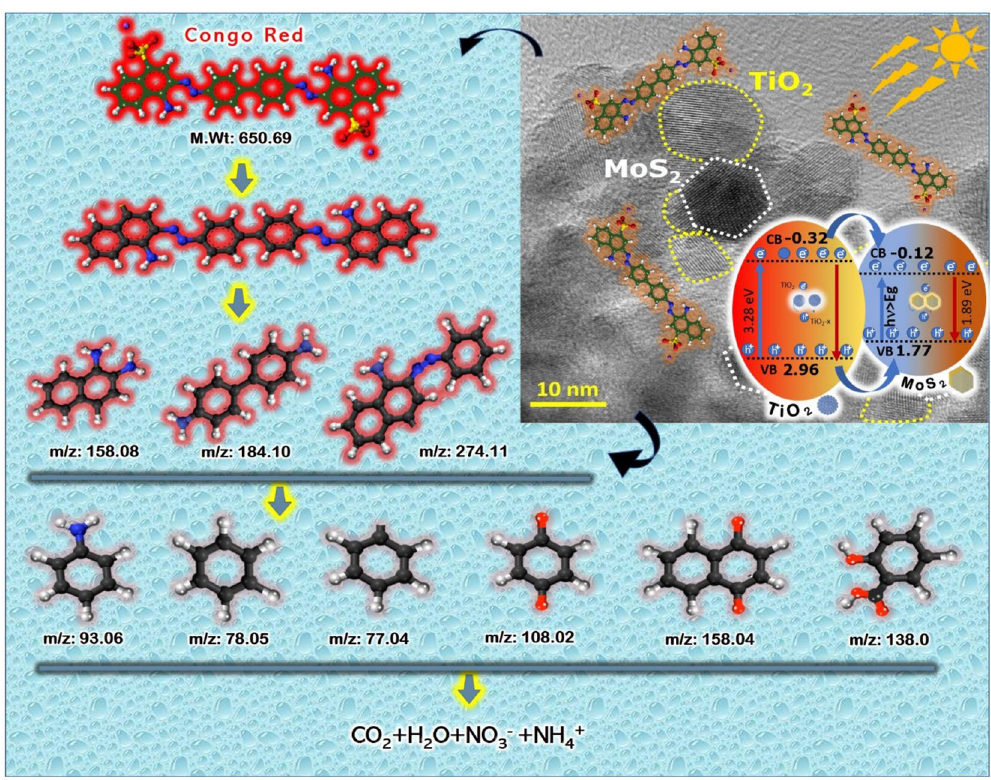
Figure 9. Mechanism of photocatalytic decomposition of Congo red dye in 2D-layered MoS 2 decorated on spherical shape